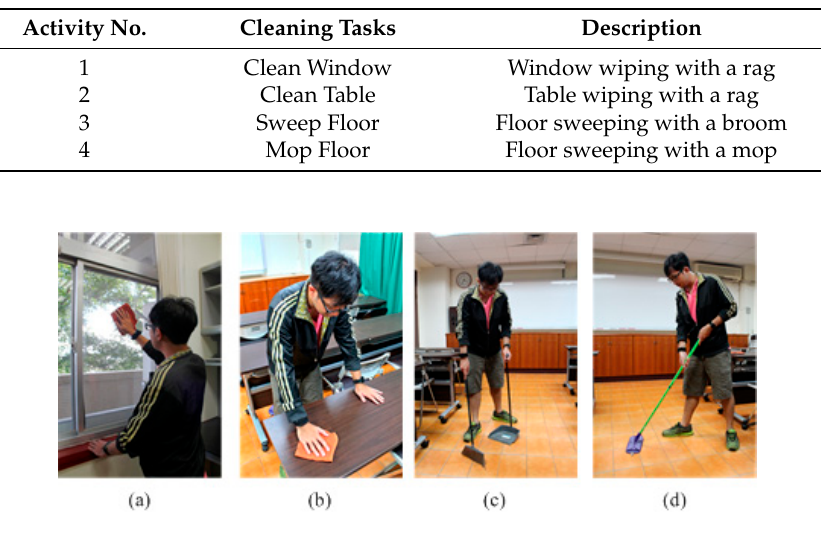
Figure 3. ( a ) Clean Window; ( b ) Clean Table; ( c ) Sweep Floor; ( d ) Mop Floor.